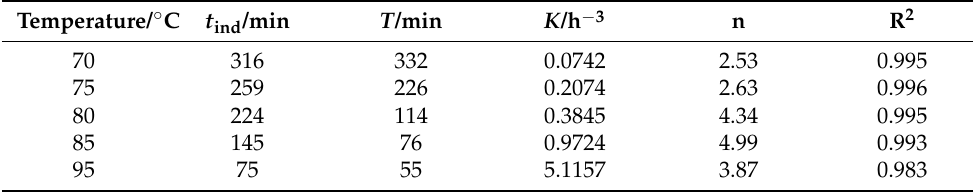
Table 7. Fitting parameters of JMA model at different temperature.